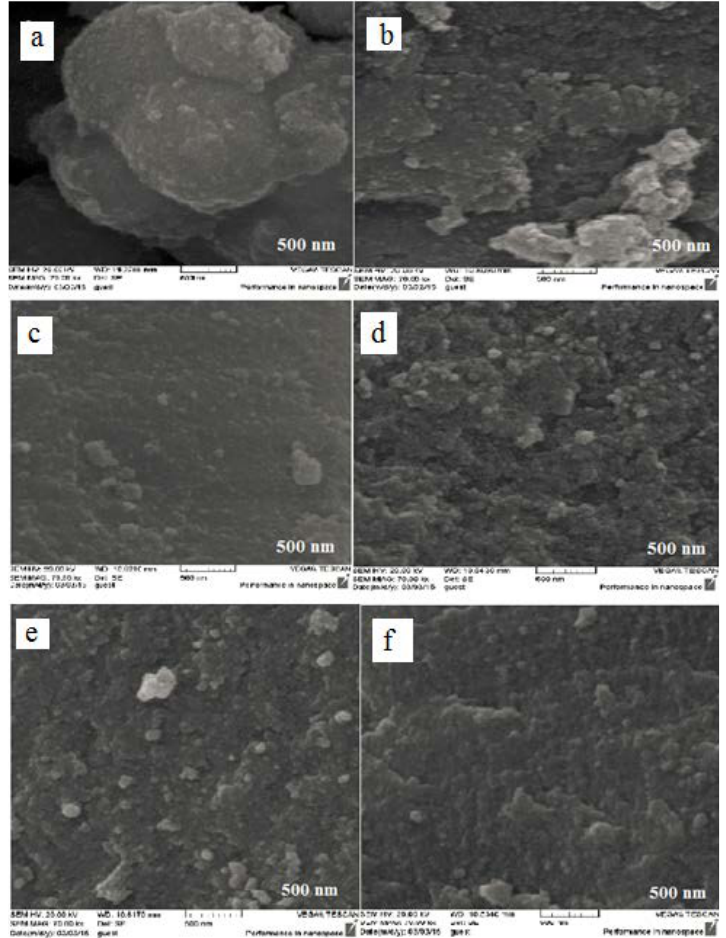
Fig. 2. SEM microghraphs of a) TiO